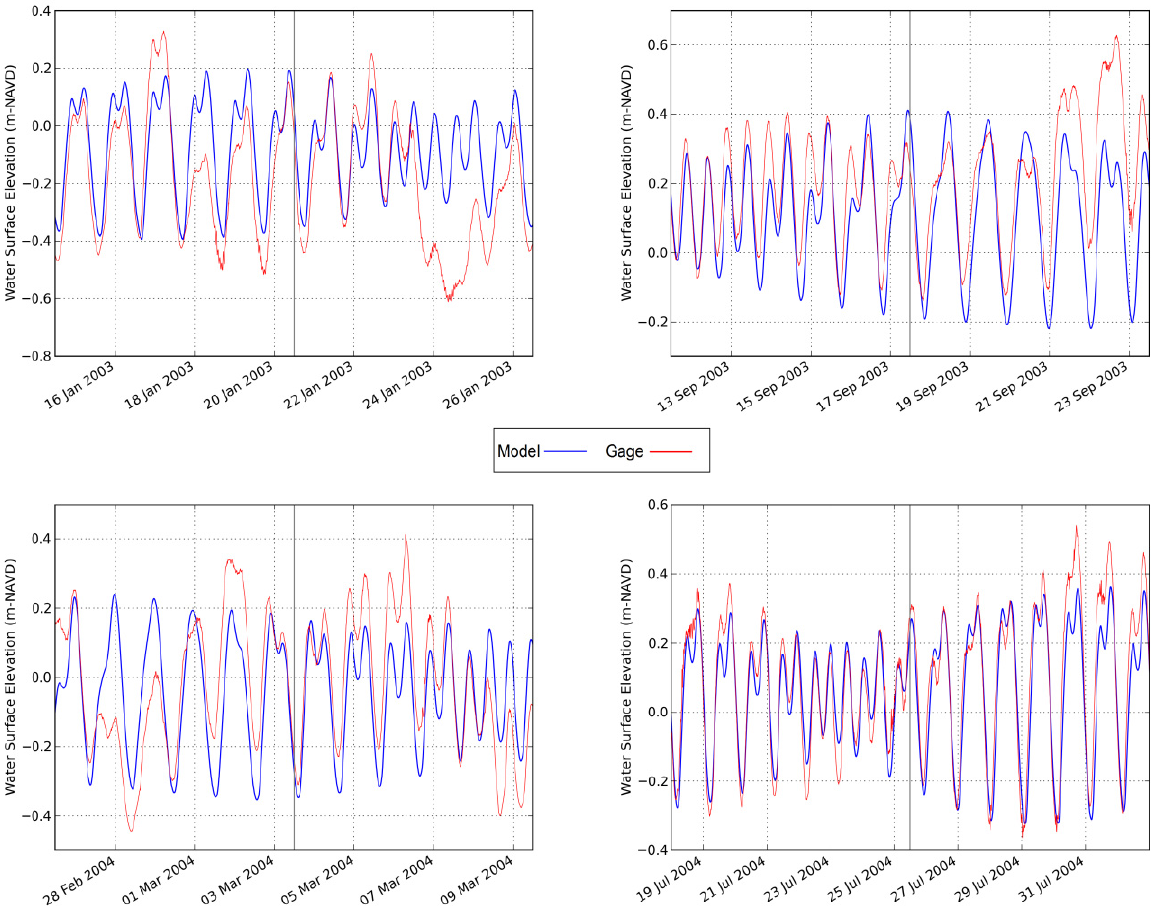
Figure 6. Predicted and observed water level time series for the Apalachicola tide gage station before and after the Radarsat-1 scene acquisition time indicated by the solid vertical line.